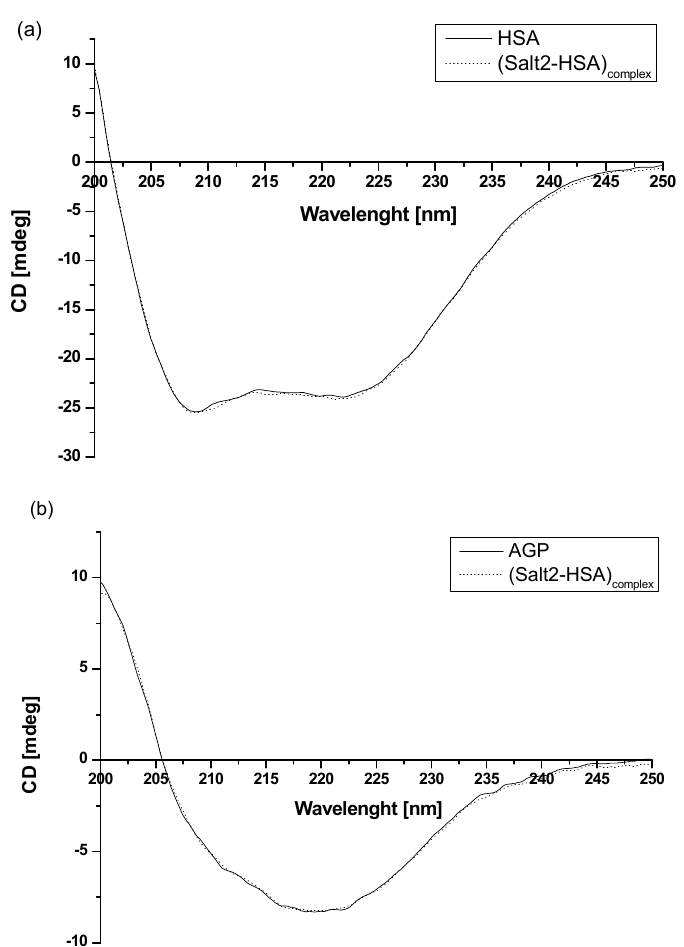
Figure Figure 6. Far-UV circular dichroism (CD) spectra of ( a ) 2·10 − 6 mol·L − 1 HSA and ( b ) 2·10 − 6 mol·L − 1 AGP in the absence and presence of Salt2. [Salt2]:[HSA]=[Salt2]:[AGP] 4:1 molar ratio.